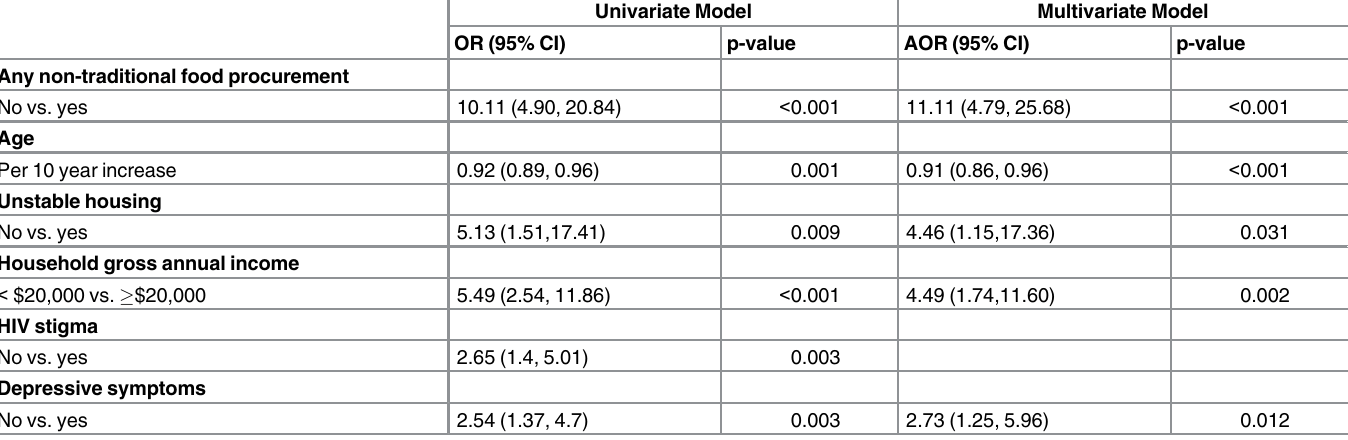
Table 7. Univariate and multivariate analyses of factors associated with food insecurity (n = 218).